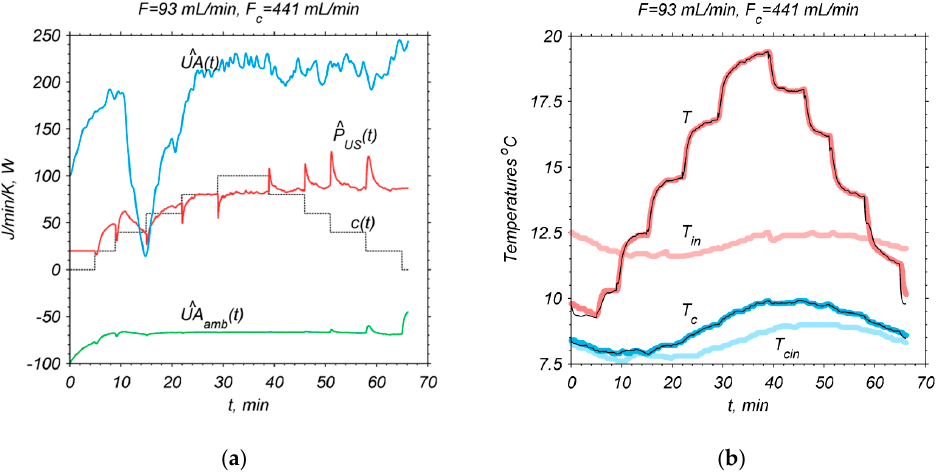
Figure 4. Experimental results for F = 93 mL / min: ( a ) estimates of unknown model parameters ˆ θ ( t ) = ˆ P ( t ) U ˆ A ( t ) U ˆ A ( t ) ; ( b ) measured temperatures (thick red and blue lines) and model predictions (black lines) for ˆ θ ( t ) .